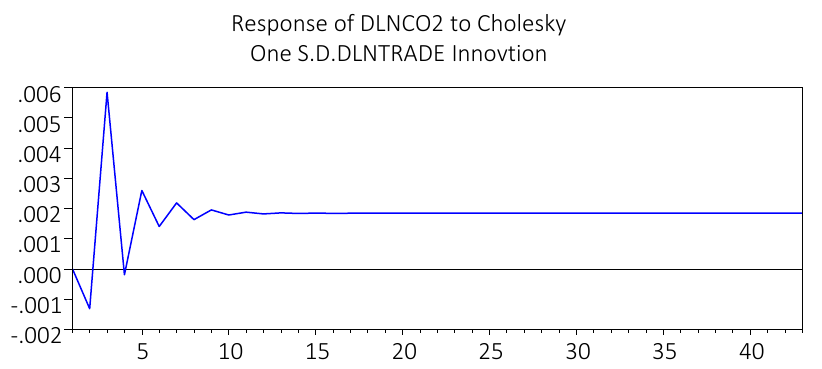
emissions by 2030 (SDG 2